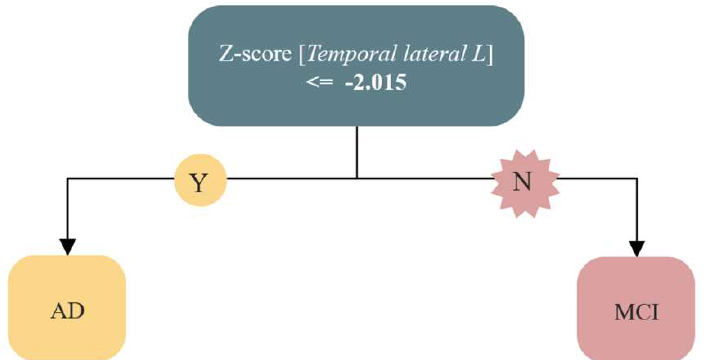
Figure 5. Prototype classification tree. Key to abbreviations: AD = Alzheimer’s disease, MCI = Mild Cognitive Impairment.